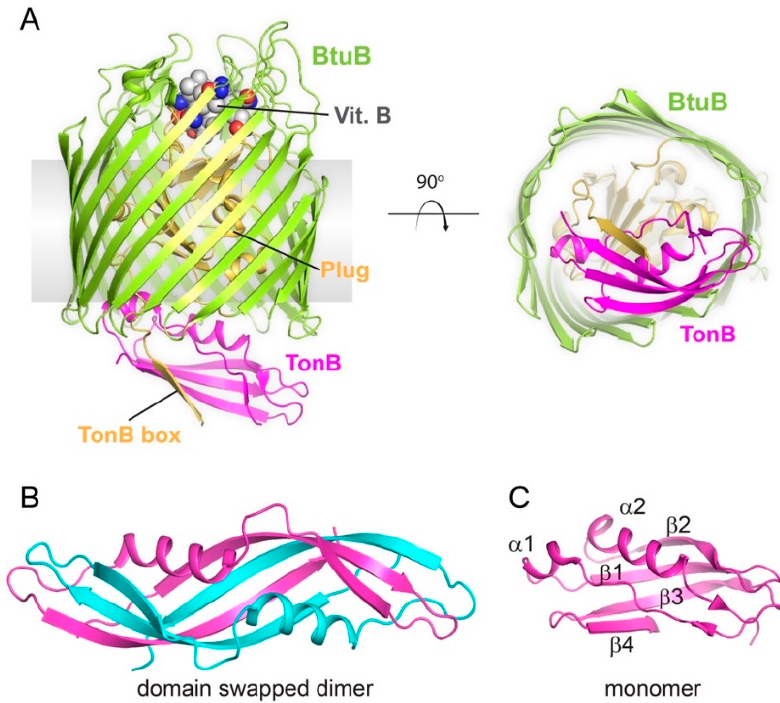
Figure 2. Structures of TonB and TonB-dependent transporters. ( A ) The X-ray structure of BtuB (green), a prototypical TonB-dependent transporter, in complex with vitamin B (spheres) and the C-terminal domain of TonB (magenta) (PBD ID 2GSK). The plug domain is shown in gold. The right panel is a view from the periplasmic face. ( B ) The X-ray structure of the TonB dimer (PDB ID 1IHR) with each monomer in different colors. ( C ) The NMR structure of the TonB monomer (PDB ID 1XX3).